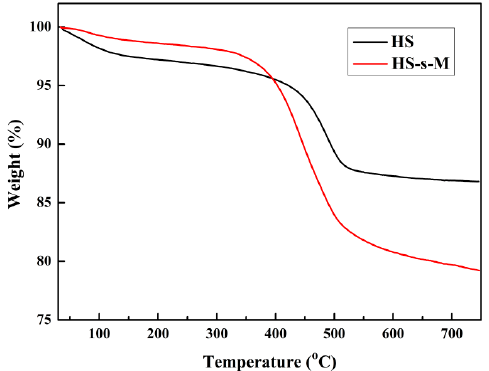
Figure 3. TGA curves of HS and HS-s-M.